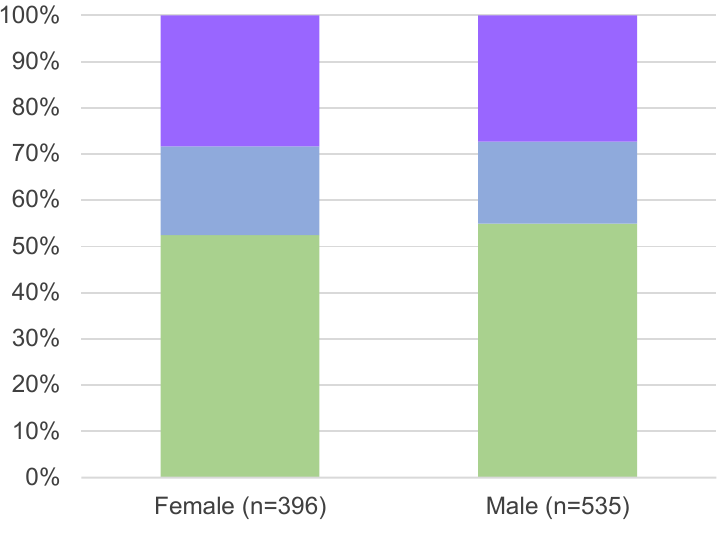
Figure 17: Distribution of fingerspelling-related tokens by nativisation category (L only) and